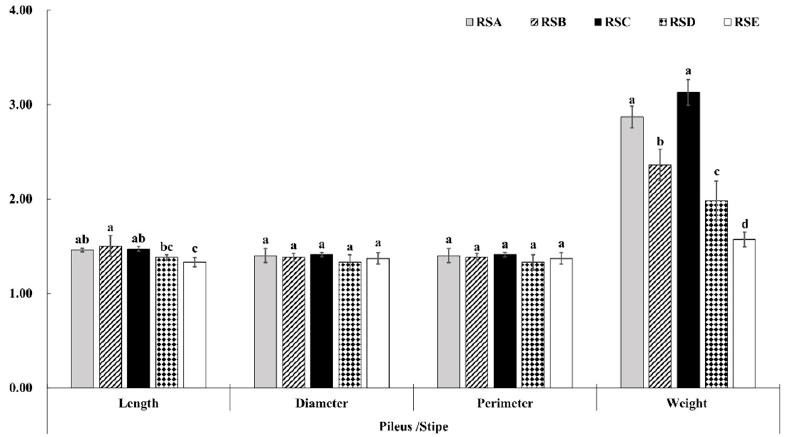
Figure 2. Effect of different rotation systems to the morphologic proportion of M. importuna , including the length, diameter, perimeter, and weight of the fruitbody (pileus/stipe); different letters indicate a statistical difference ( p < 0.05). Table 2. Effect of different rotation systems on yield of M. importuna . Different letters indicate a statistical difference ( p <